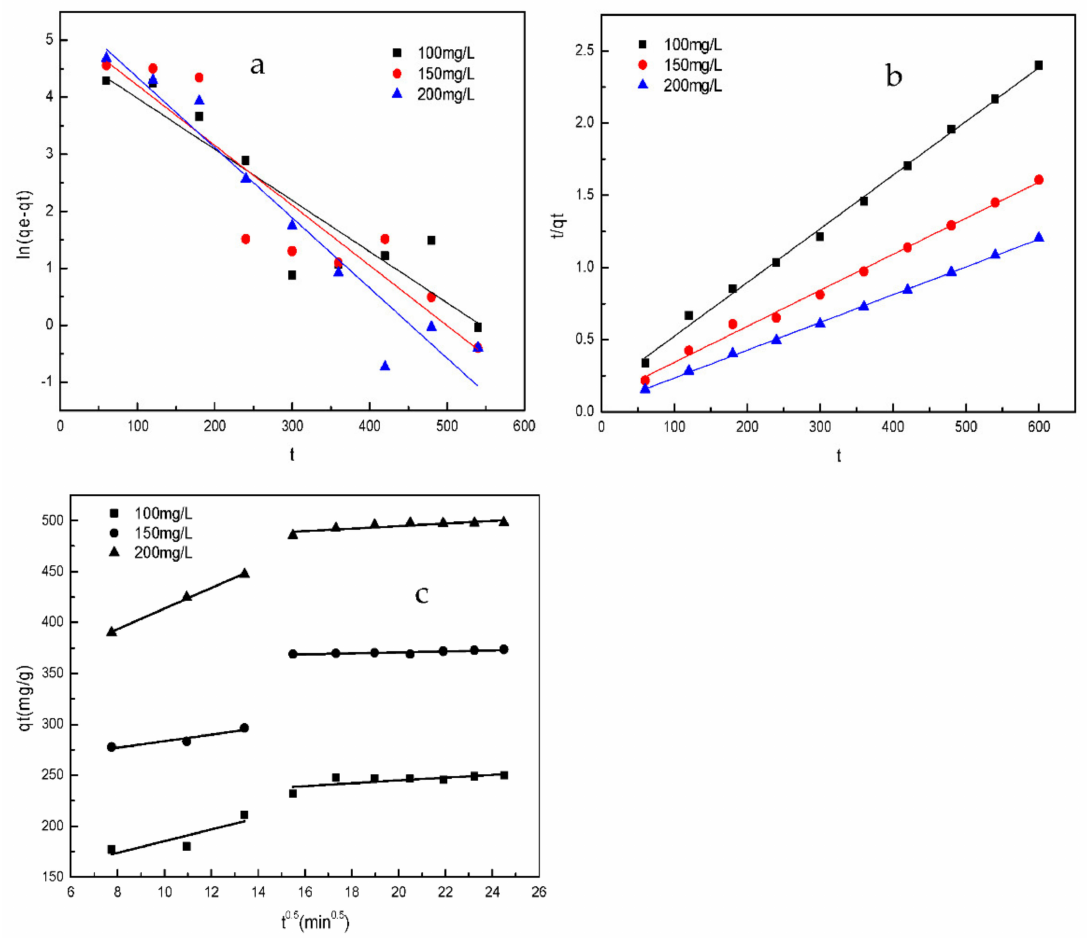
Figure 10. The fit of the pseudo-first-order ( a ), pseudo-second-order ( b ), and intra-particle diffusion ( c ) models for the adsorption of sulfonated lignite by filter paper-templated Mg-Al metal oxides. Table 2. Adsorption kinetic parameters of the pseudo-first-order and pseudo-second-order models for the adsorption of sulfonated lignite by filter paper-templated Mg-Al metal oxides. Concentration